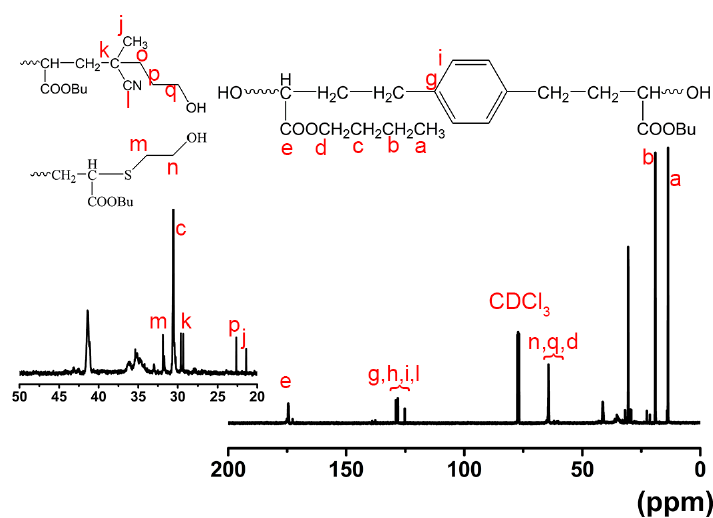
Figure 4. 13 C NMR spectrum of the PBA synthesized by DITP of the n -BA with feed molar ratio of [ n -BA]/[ACPO]/[DIX] = 16/0.08/1 at 60 °C for 24 h ( M n,GPC = 3200 g/mol).